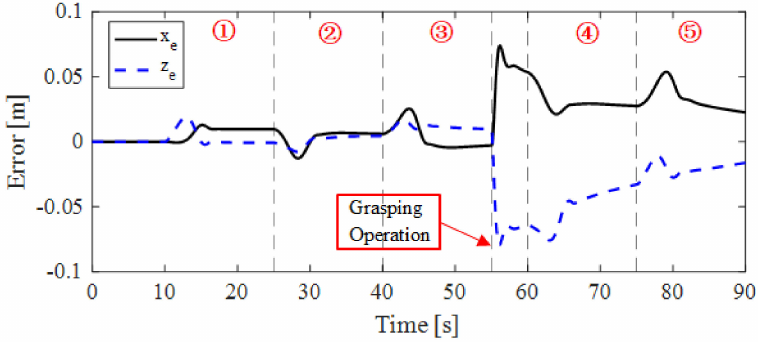
Figure 13. The position tracking error of end effector with vehicle position and attitude